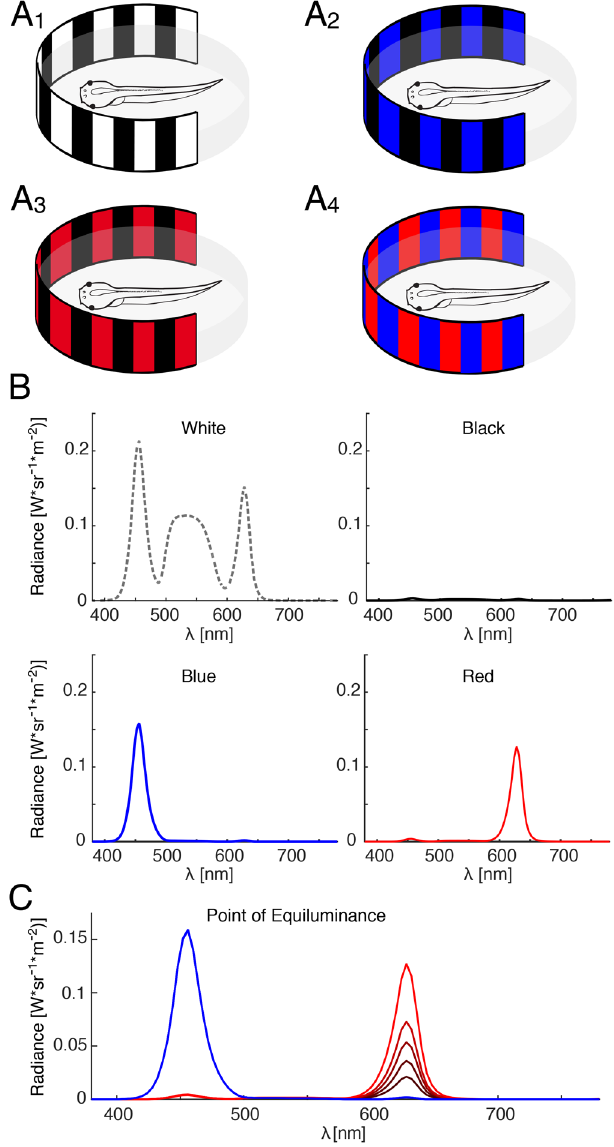
Figure 1. Color patterns and wavelength spectrum of large-field visual motion stimuli. (A) Schematics of color motion stimuli with black–white (A 1 ) , black–blue (A 2 ) , black–red (A 3 ) and red–blue (A 4 ) vertical stripes that were projected onto a cylindrical screen around the centered semi-intact preparation of a Xenopus tadpole. (B) Spectra of white, black, blue and red light emitted by the projectors at maximal intensity. (C) Graph depicting the method to identify the point of equiluminance; note that the intensity of the blue stripes was held constant, whereas the intensity of the red stripes was gradually altered. Figure assembled with Affinity Designer (version